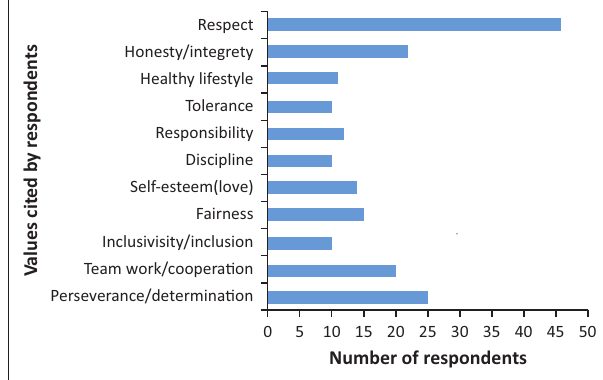
FIGURE 2: The most cited